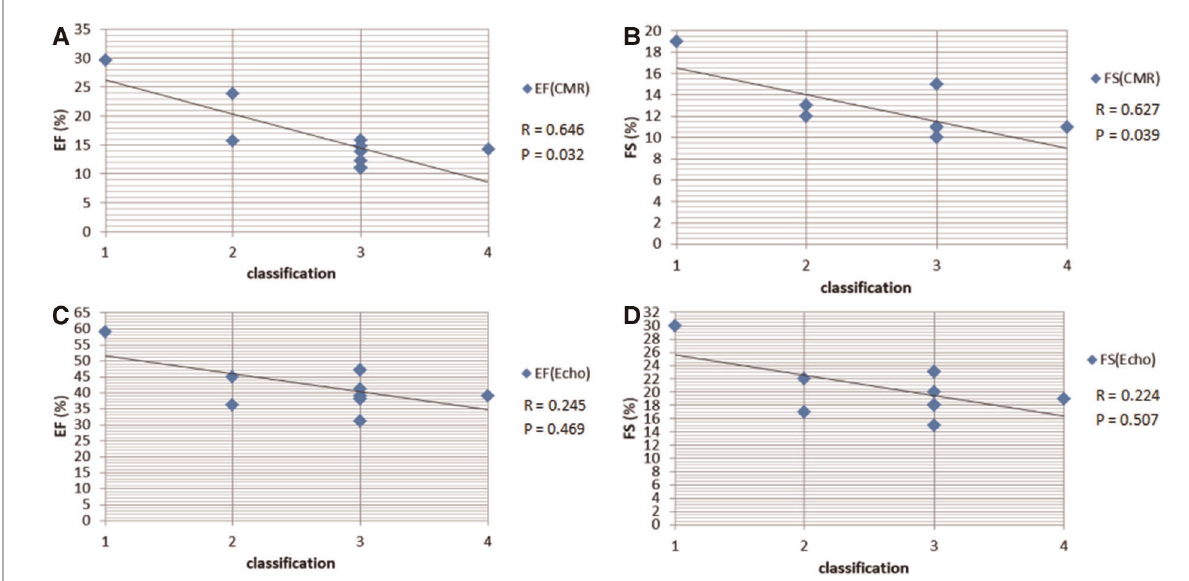
FIGURE 4 ( A,B ) Scatterplot of clinical cardiac function classi fi cation and EF and FS measured by CMR in patients with EFE. ( C,D ) Scatterplot of clinical cardiac function classi fi cation and EF and FS measured by Echo in patients with EFE. EF, ejection fraction; FS, fractional shortening; CMR, cardiac magnetic resonance; EFE, endocardial fi